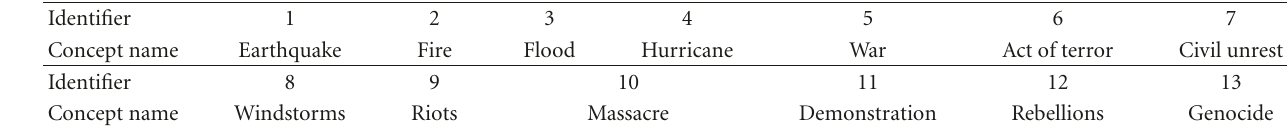
Table 1: Examined